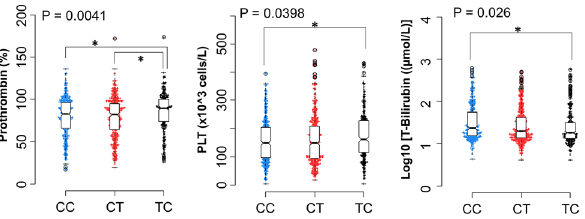
Figure 4. Association of PD-1 haplotypes with distinct laboratory parameters in HBV patients. Box-plots illustrate median values with 25 and 75 percentiles with whiskers to 10 and 90 percentiles; p- values were calculated by Mann–Whitney